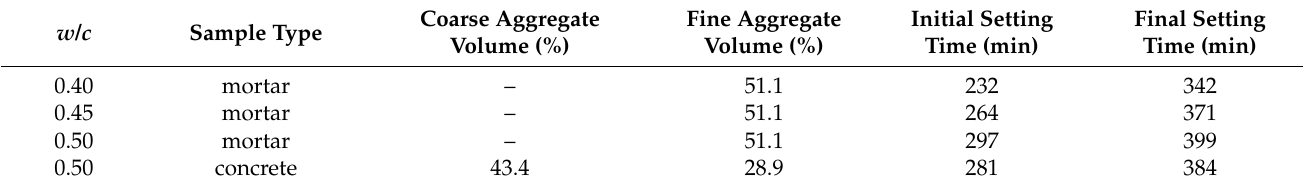
Table 1. Mixture designs and setting times of mortar and concrete